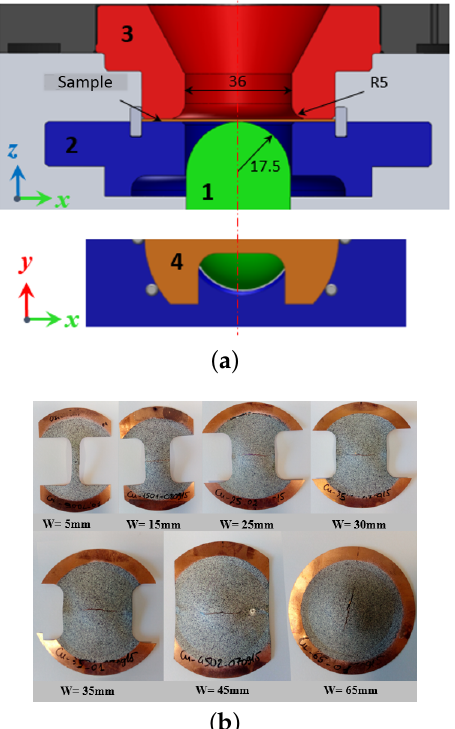
Figure 4. ( a ) Left-hand part: tools of the Nakazima test, (1) punch, (2) blank-holder, (3) die, (4) sample. ( b ) Right-hand part: geometries of the samples for the Nakazima